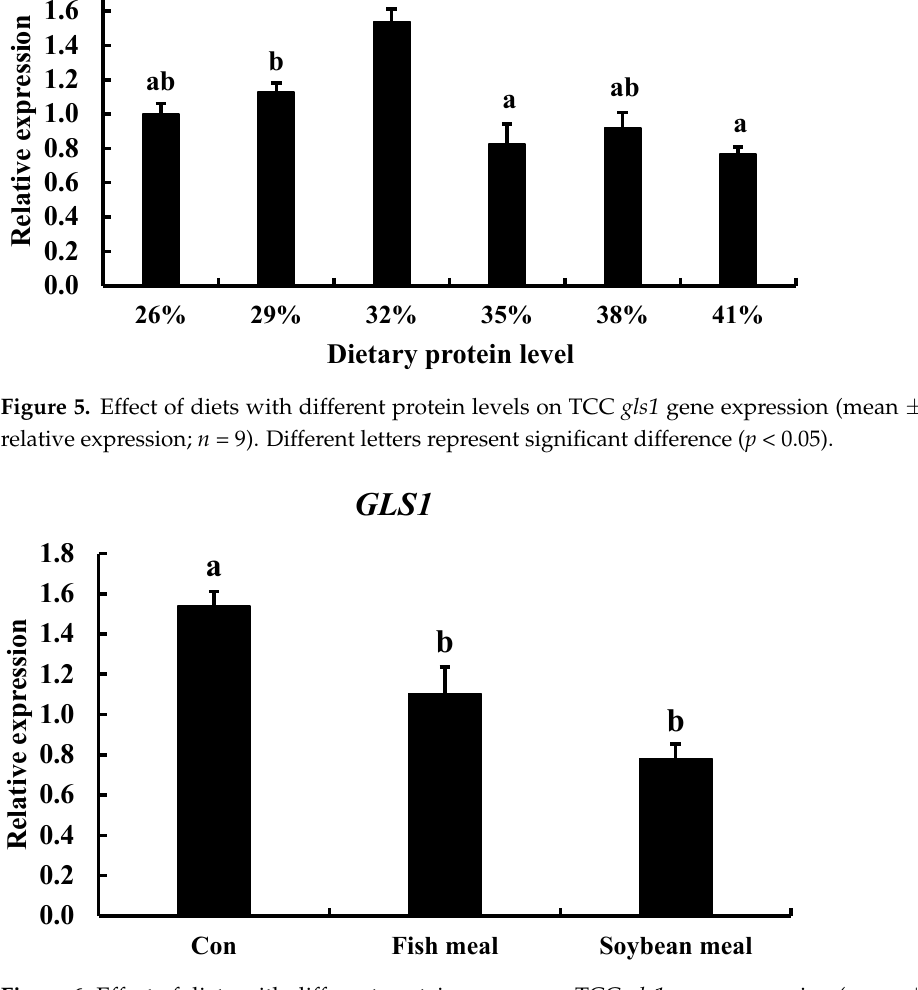
Figure 6. Effect of diets with different protein sources on TCC gls1 gene expression (mean ± SE of relative expression; n = 9). Different letters represent significant difference ( p < 0.05).